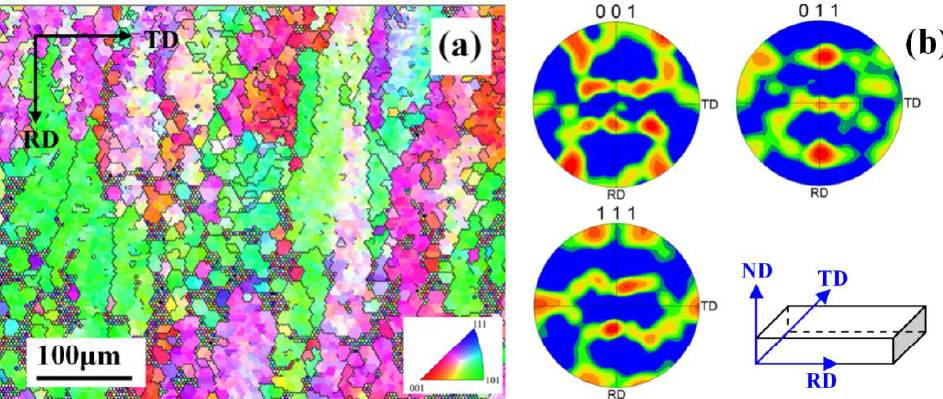
Figure 1. Microstructures of the as-hot-rolled sample: ( a ) EBSD-derived IPF maps; ( b ) pole figures. RD and TD are the rolling direction and the transverse direction, respectively.